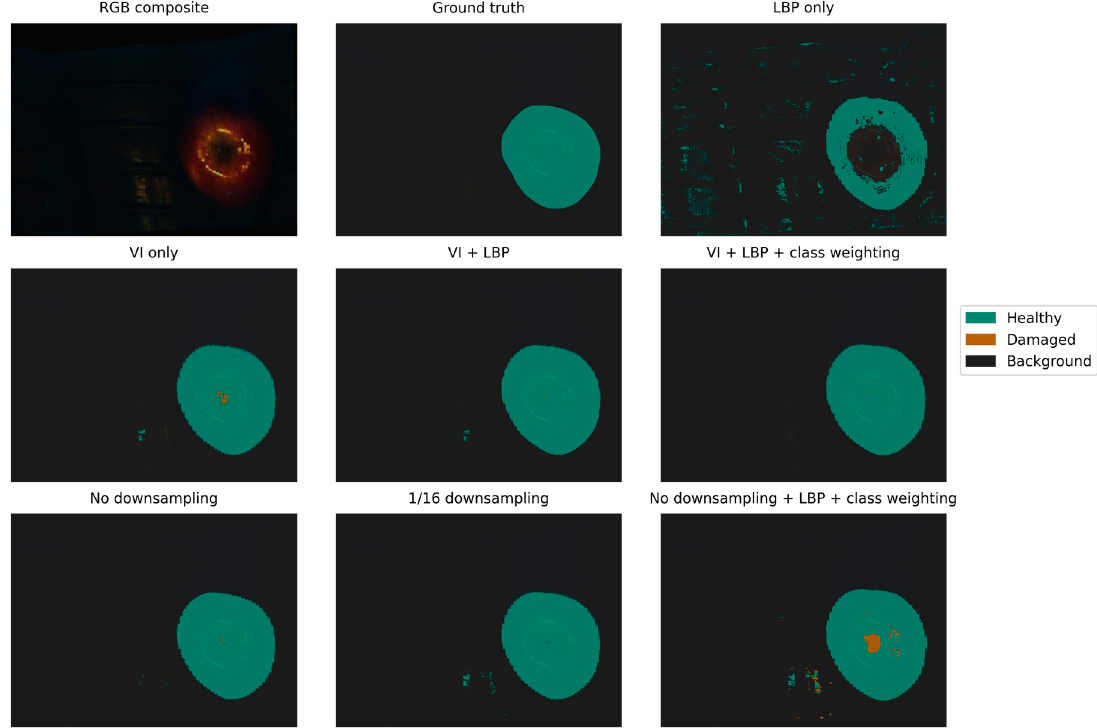
Figure 4. Classification results for a healthy apple.